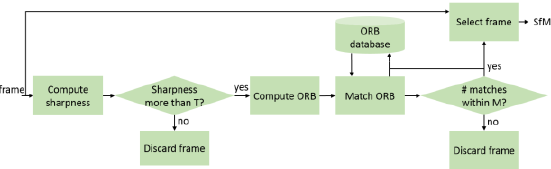
Figure 3: Block diagram of the key-frame selection algorithm. T is a threshold applied to the sharpness value. M is the interval of good matches to select the frame.